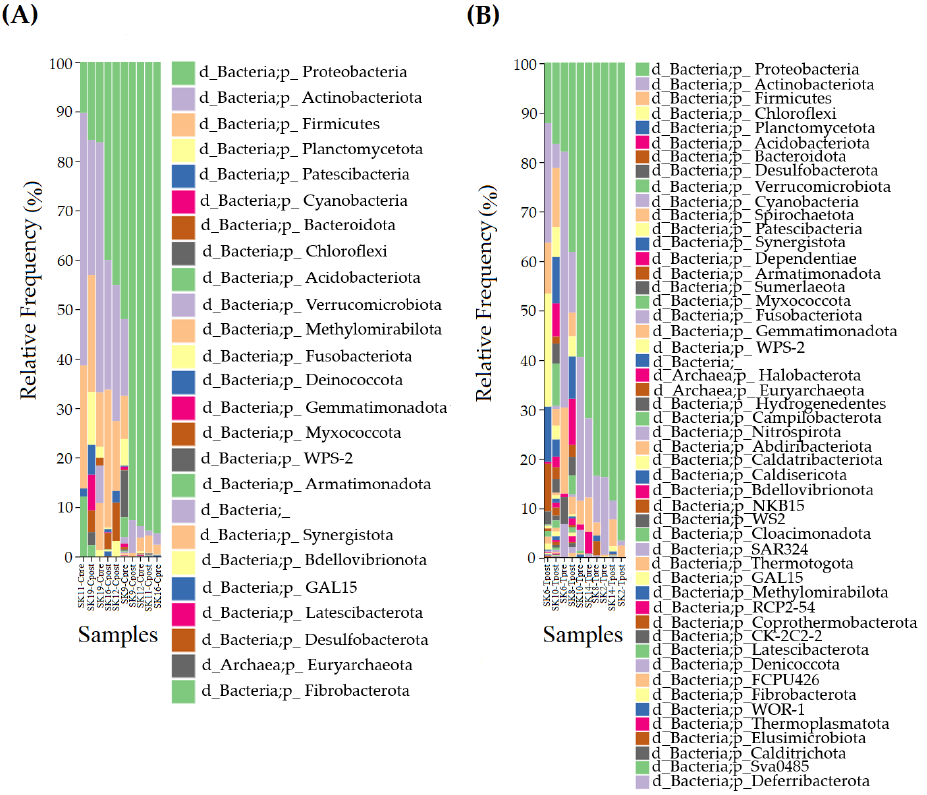
Figure 2. Taxonomical assignment for the control and treatment samples. The comparison of phylum in the control ( A ) treatment ( B ) samples.